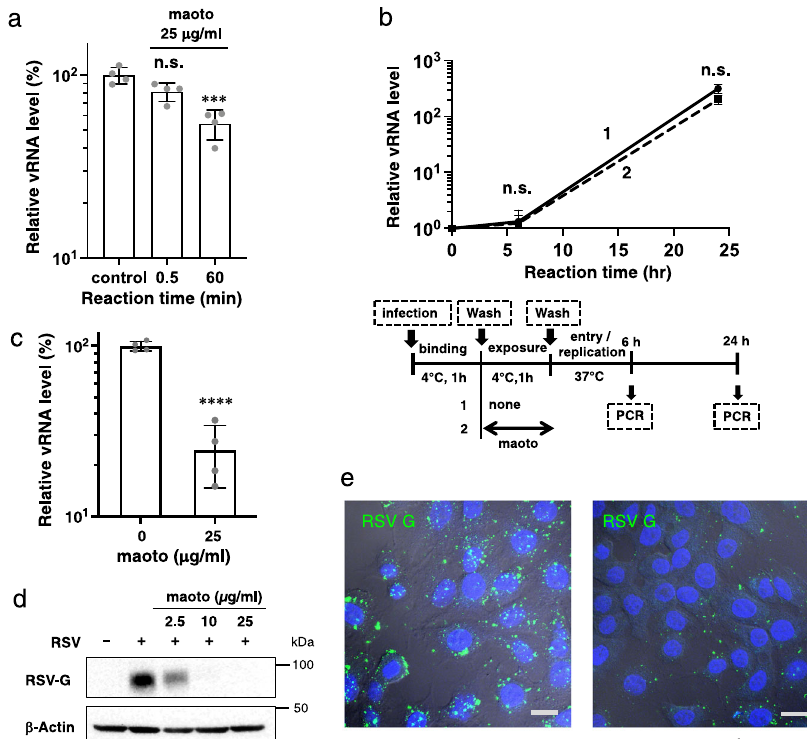
Fig. 2 Direct inhibitory effect of maoto on RSV. a Maoto directly inhibits the RSV infectivity. High-concentration RSV was incubated with maoto (25 µ g/ mL) for 0.5 or 60 min. A549 cells were inoculated with the treated RSV (moi 1) and cultured for 6 h (maoto concentration 0.625 µ g/mL). Levels of viral RNA in the cells were measured by RT-PCR. One-way ANOVA followed by Dunnett ’ s post-test. *** P < 0.001 and n.s.; not signi fi cant. b Maoto does not disrupt RSV. RSV was allowed to attach to cells for 1 h on ice and then incubated for 1 h in the presence or absence of maoto. After washing, cells were cultured at 37 °C for 24 h and viral RNA levels in the cells were measured by RT-PCR. The culture conditions are illustrated below. n.s.; not signi fi cant. c Reduction of cell-surface viral RNA levels by maoto. A549 cells were inoculated with RSV (moi 1) and simultaneously treated with maoto on ice for 1 h. After washing, viral RNA levels in the cell were measured by RT-PCR. Unpaired Student ’ s t -test was used. **** P < 0.0001 versus 0 µ g/ml. d Reduction of cell surface RSV G protein levels by maoto. A549 cells were inoculated with RSV (moi 1) and simultaneously treated with maoto on ice for 1 h. RSV G protein in the cells was detected by western blotting. e Visualization of RSV G protein on the cell surface. Merged photos show RSV G protein (green), DAPI (blue), and cells. a – c show individual values and mean±error bars SD ( a , c : n = 4, b : n = 3). e , Scale bars indicate 10 µ